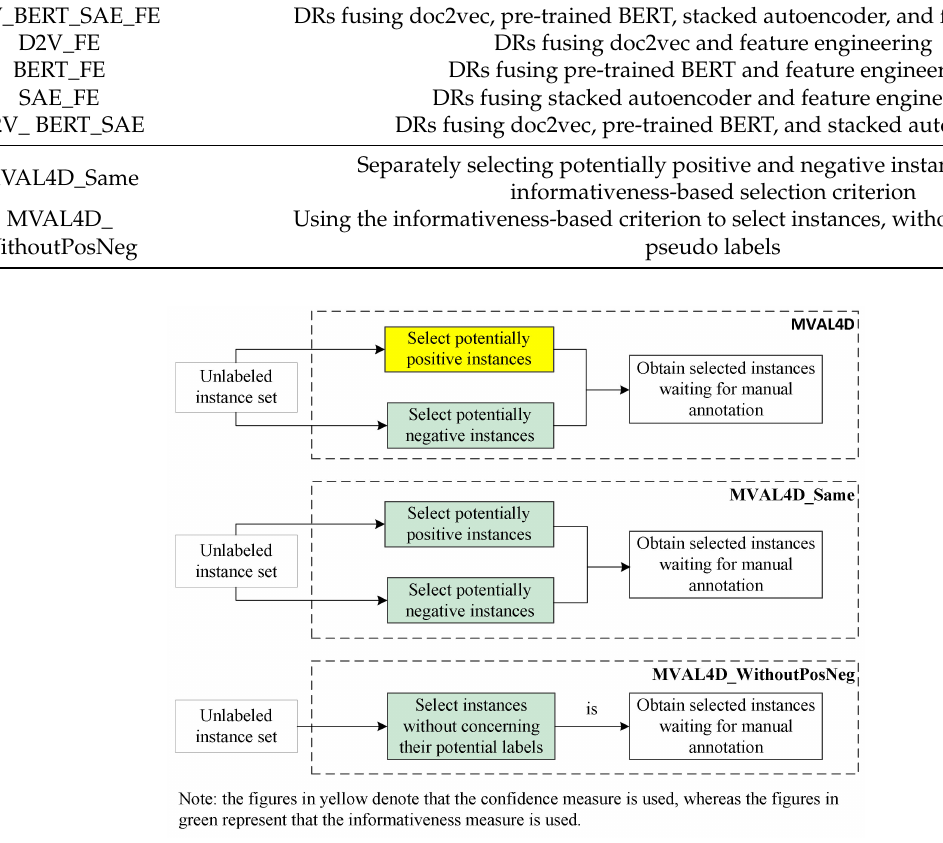
Figure 4. Different selection strategies compared in the